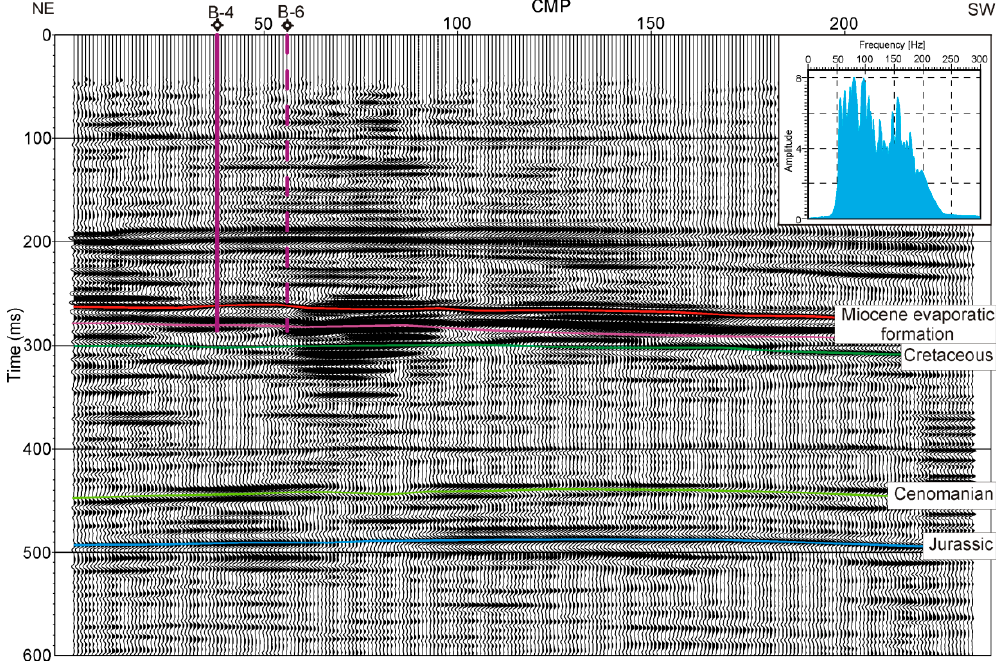
Figure 7. Seismic profile 2 and its amplitude spectrum with interpretation and wells position. Well B-6 is projected from 25 m.